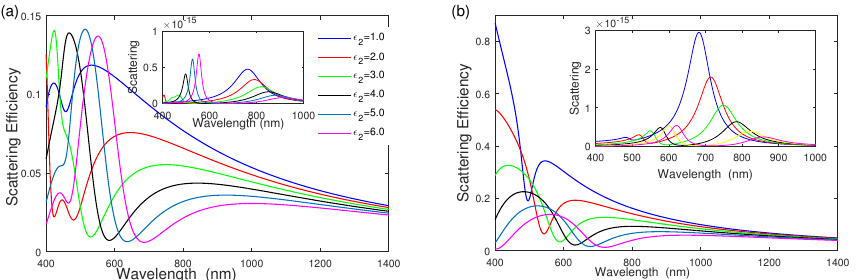
Figure 5. The effect of middle dielectric function ε 2 on scattering efficiency and scattering. ( a ) Silver– dielectric–gold nanoshell with ε 4 = 4.0, ( b ) gold–dielectric–silver nanoshell with ε 4 = 4.0, respectively.